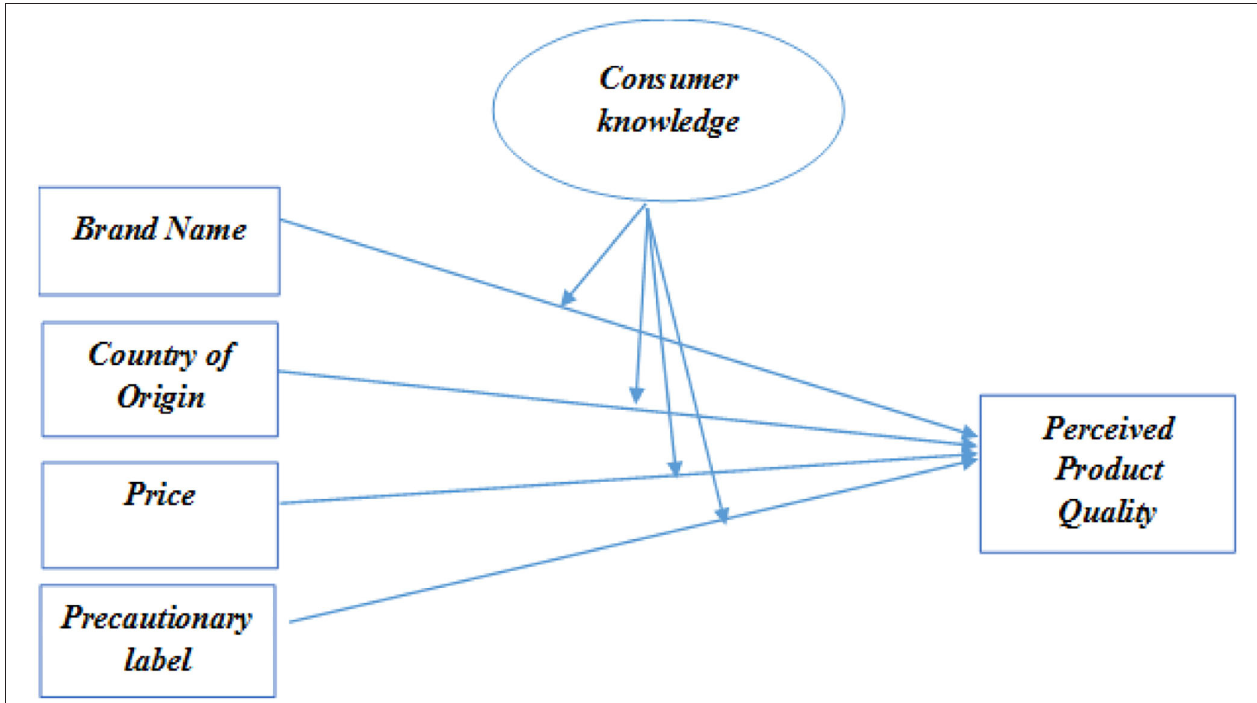
FIGURE 1 | Theoretical